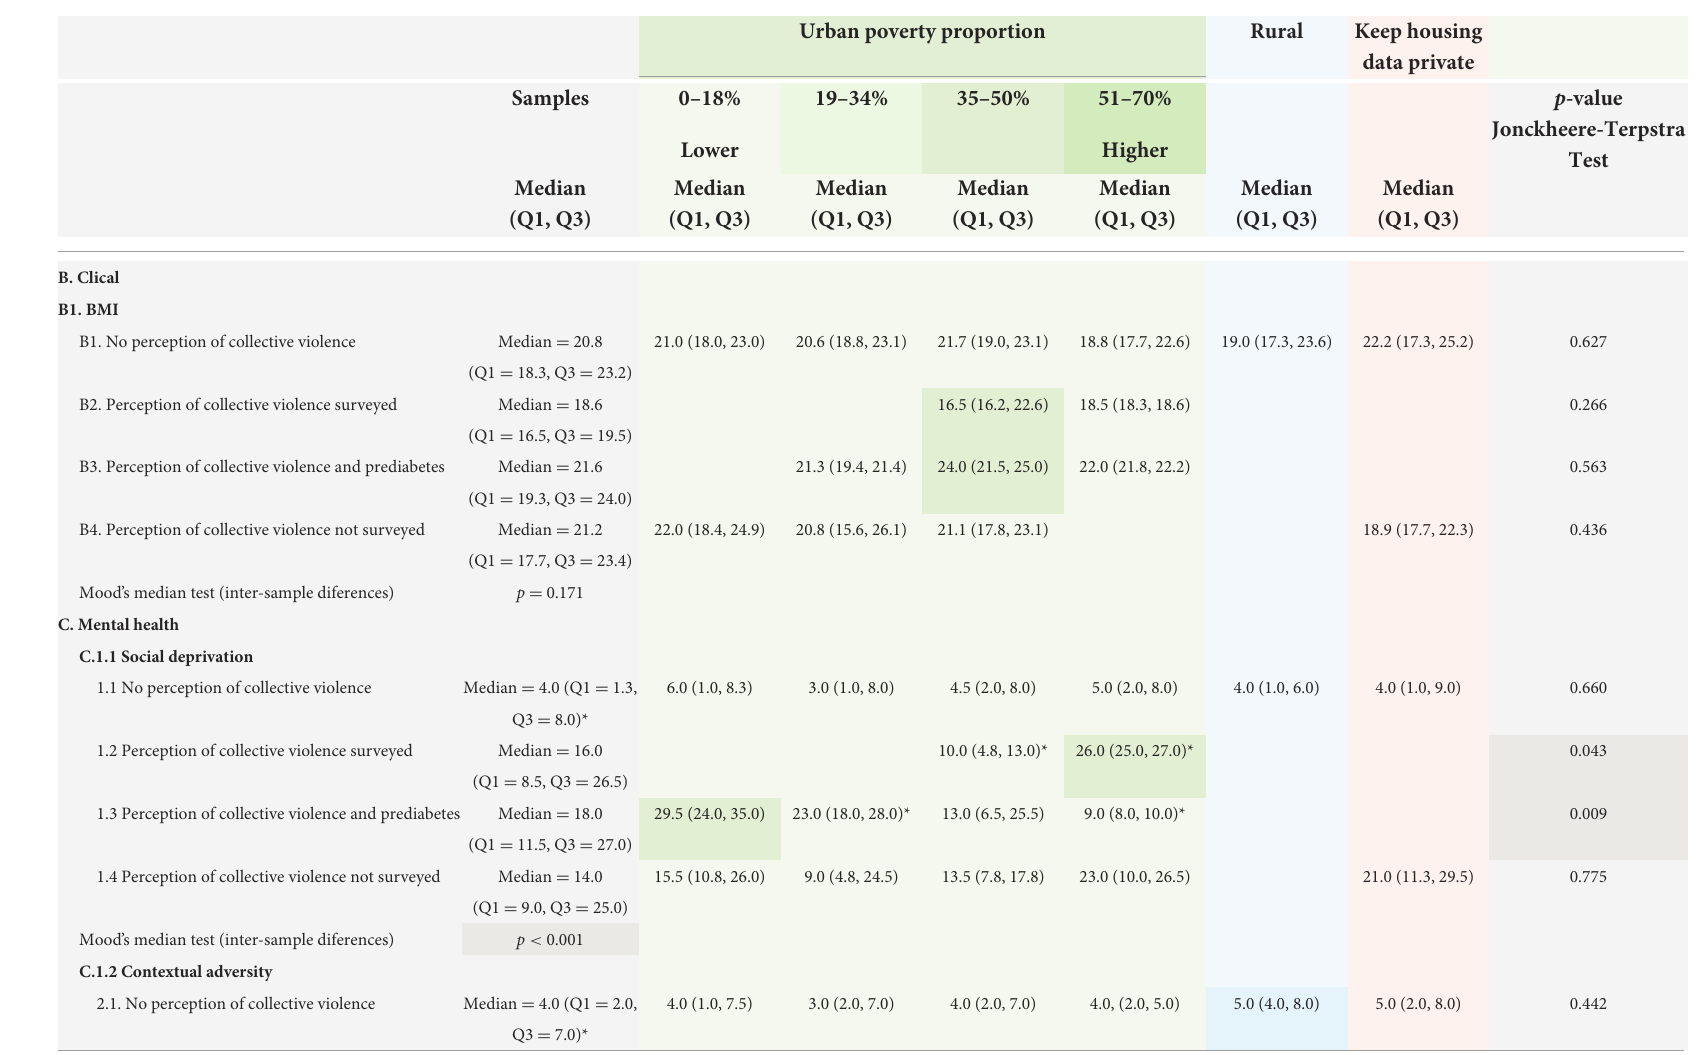
TABLE 2 Clinic features by urban poverty sector among the